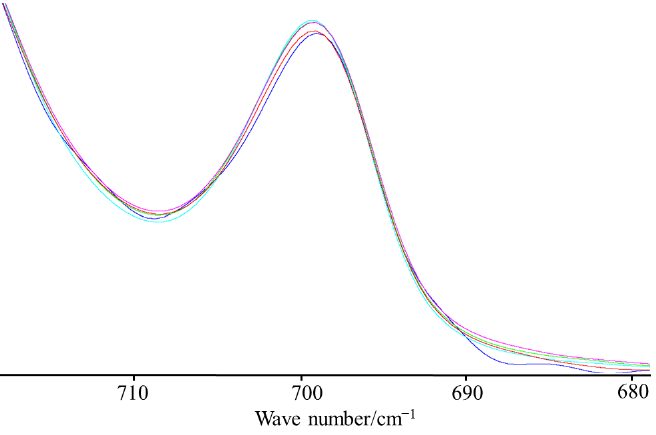
Figure 11. Infrared spectra of SBS modified asphalt, whether it contains additives at 699 cm − 1.